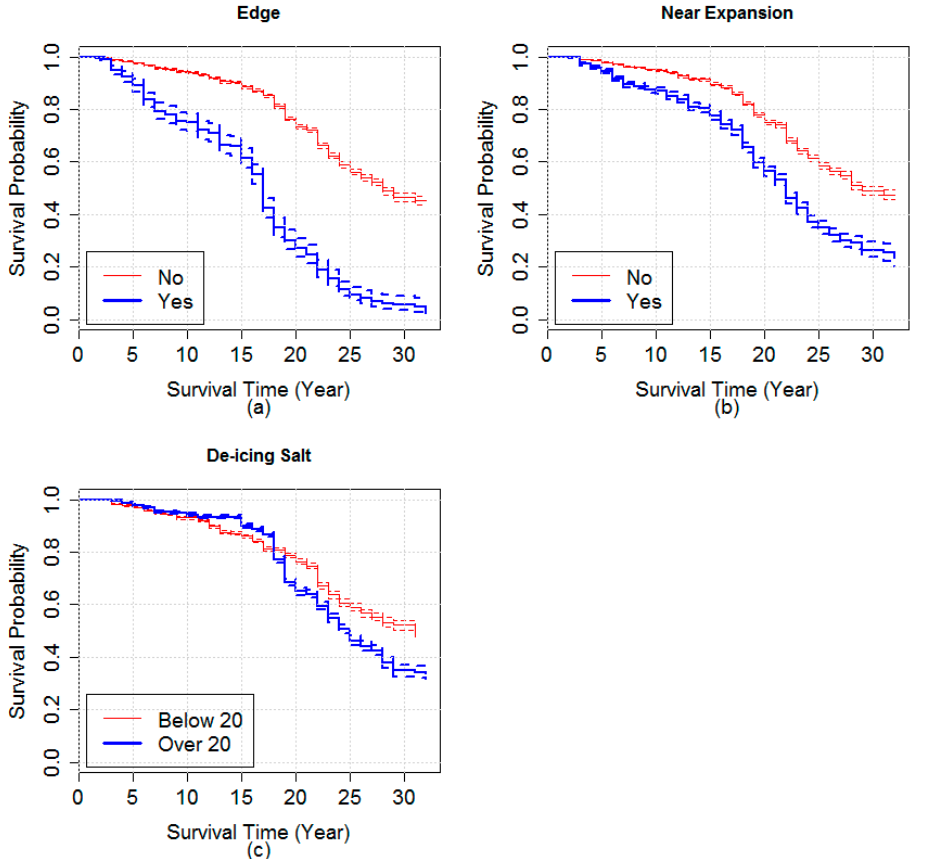
Figure 8. Survival probability of some category variables in East Japan; ( a ) edges; ( b ) near expansion; ( c ) de-icing salt.